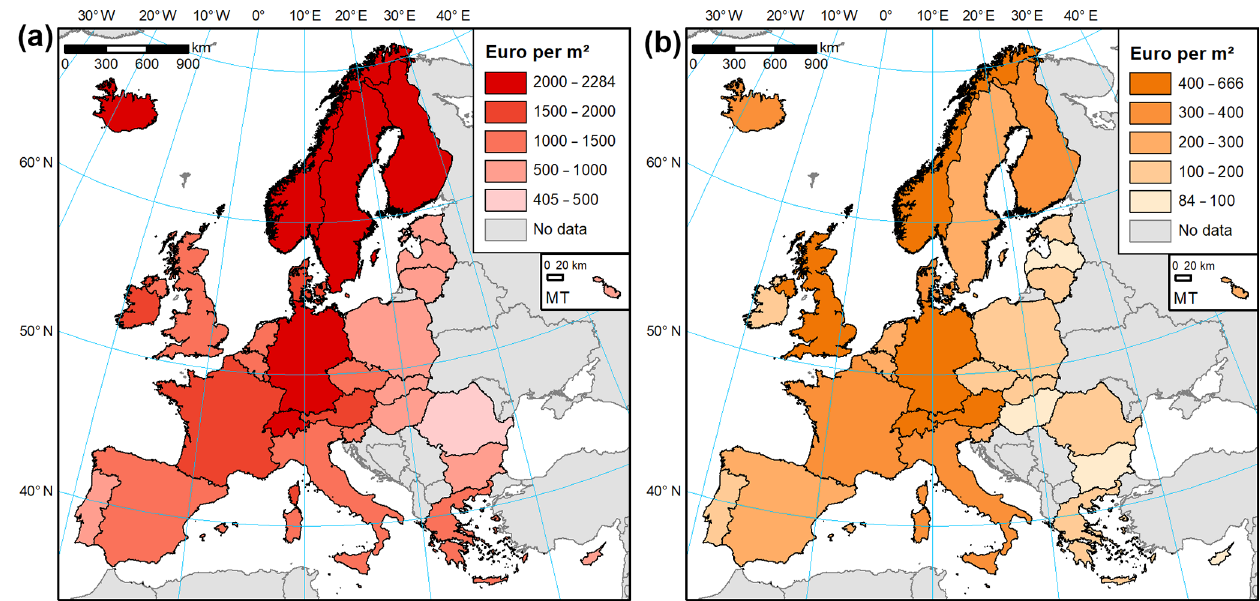
Figure 5. Value of (a) residential buildings and (b) household contents per square metre of floor space as of 2017. Country boundaries from EuroGeographics (Eurostat, 2019b).